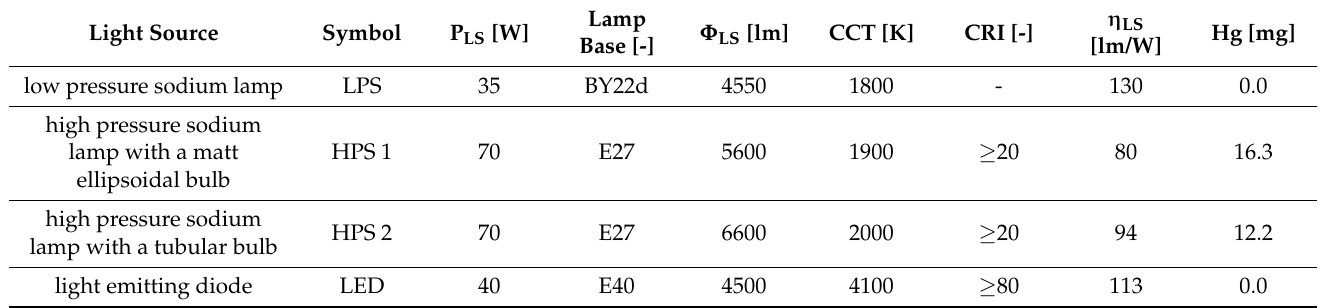
Table 1. Basic technical data of the light sources